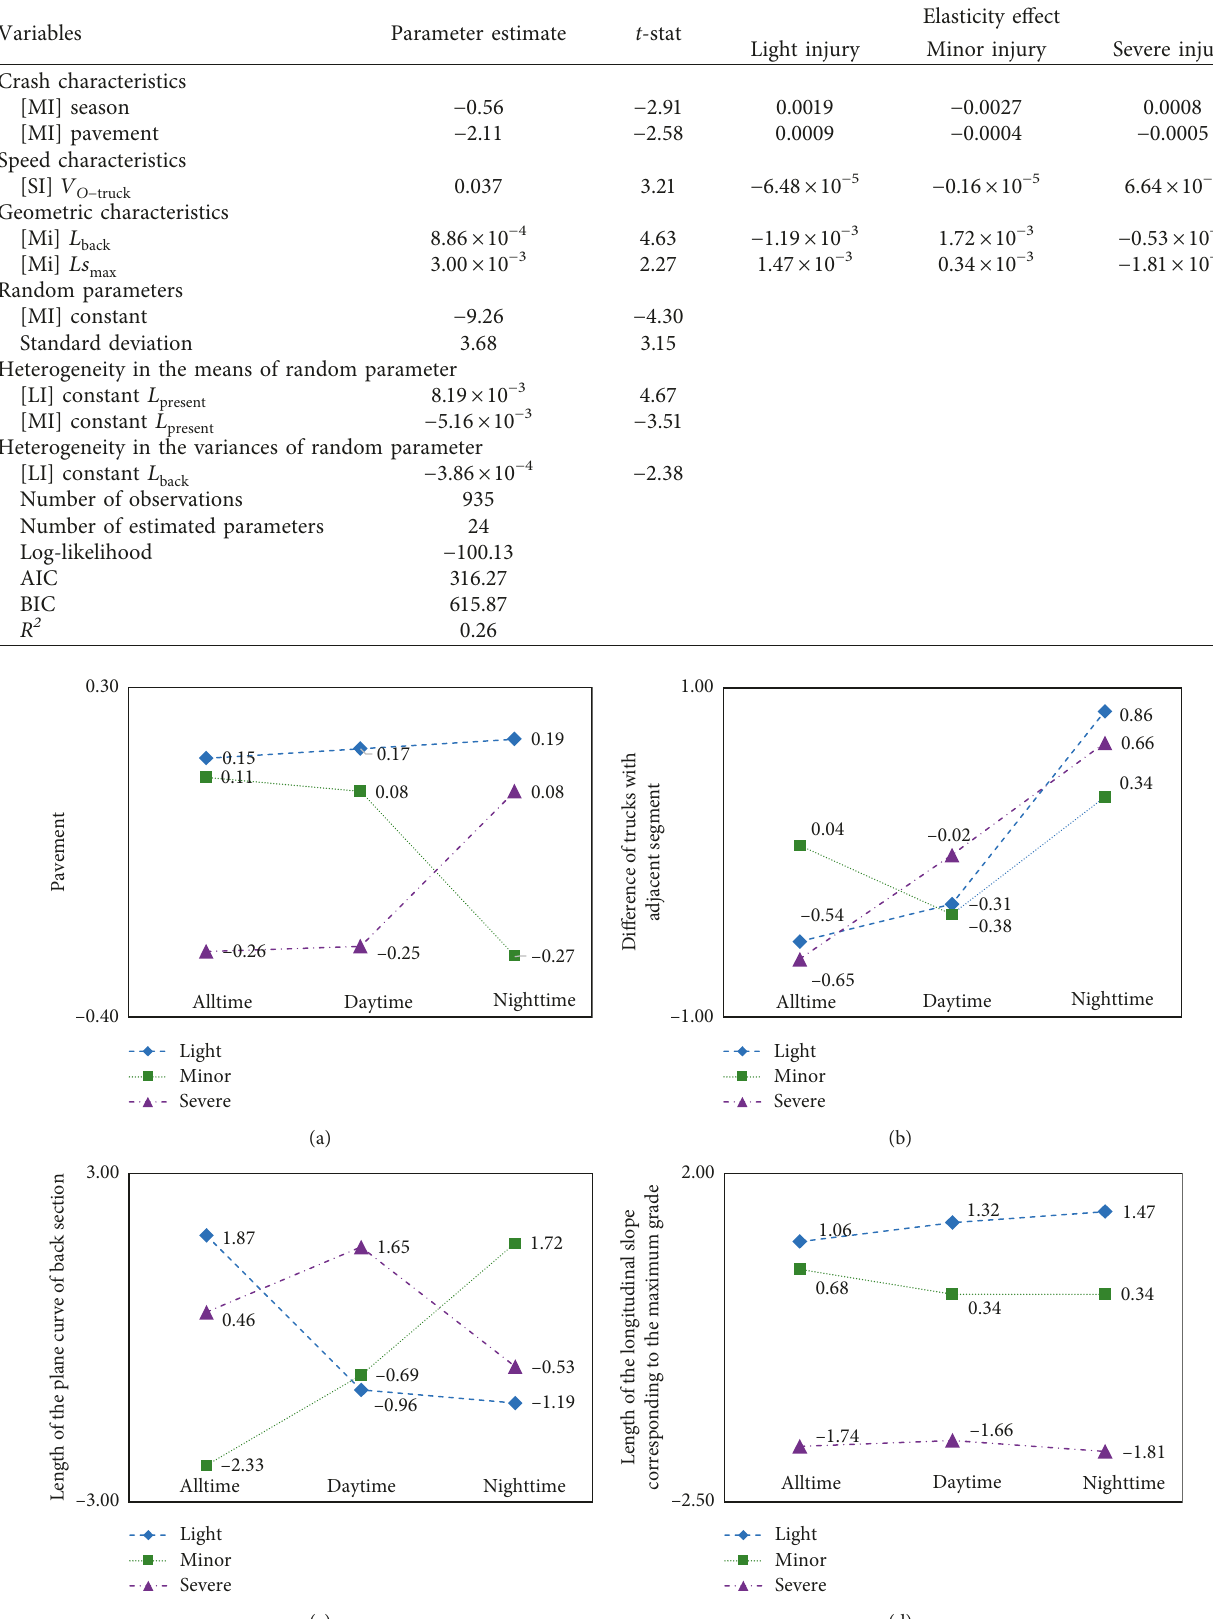
Table 7: Model results of the random parameter logit model with heterogeneity in means and variance for nighttime crashes.